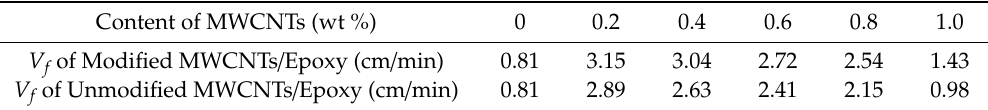
Table 2. Viscosity of the MWCNTs/epoxy resin mixture solution.